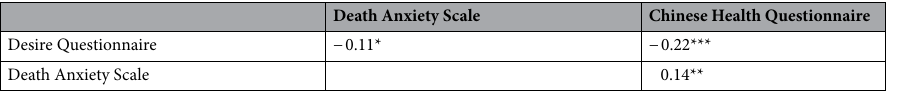
Table 6. Partial correlations between Desire Questionnaire, Death Anxiety Scale, and Chinese Health Questionnaire scores, controlling for age, gender, and education. * p < 0.05, ** p < 0.01, *** p < 0.001 (two-tailed).